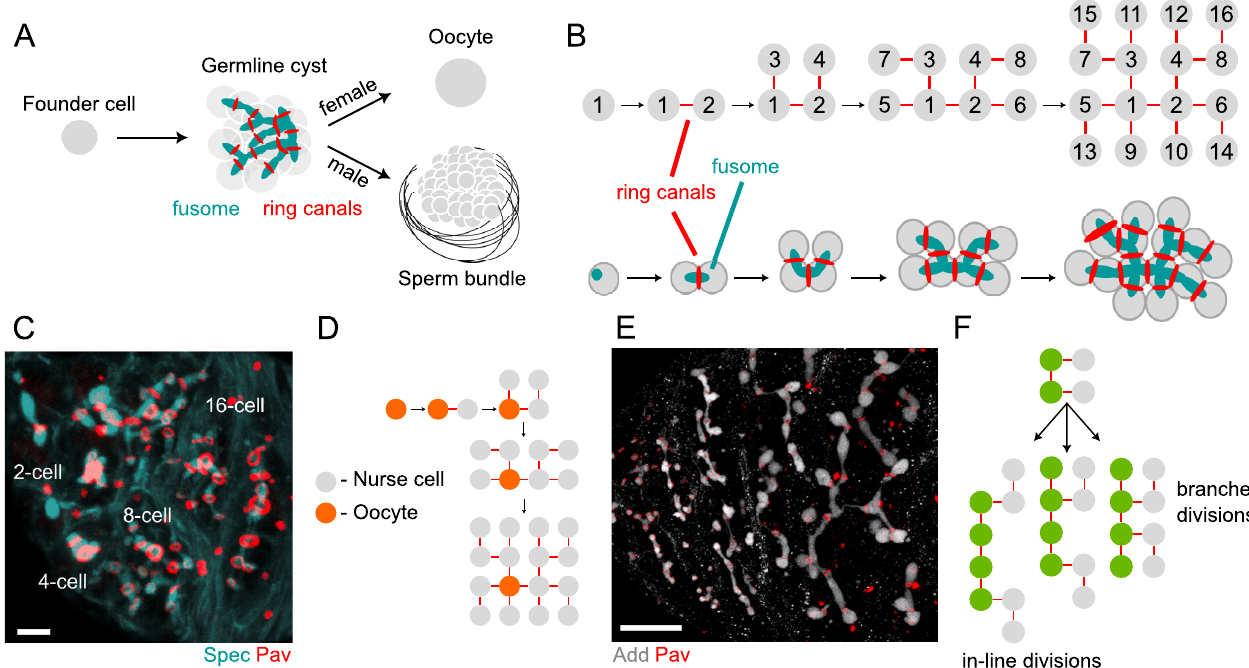
Fig 1. Fusome formation, structure, and patterns of division. A) Schematic of cyst formation during oogenesis and spermatogenesis in Drosophila melanogaster . A founder cell gives rise to a germline cyst whose 16 cells are connected through ICBs or ring canals. During oogenesis, one cell becomes the oocyte while the remaining cells serve a supporting role. During spermatogenesis, two subsequent meiotic divisions with incomplete cytokinesis generate 64 haploid spermatids. In both sexes, germline cysts contain a fusome, which permeates the cysts through the ring canals. B) Schematic of the four rounds of synchronous cell divisions that give rise to the female germline cyst, comprising 16 cells (nodes) connected by 15 ring canals (edges). The fusome (cyan) derives from the spectrosome and grows with each cell division; association of the fusome with one of the two mitotic centrosomes orients the planes of cell division, ensuring the stereotypical and maximally branched pattern in female cysts. C) Projection of a 3D image showing the fusome ( α -Spectrin, Spec) permeating the cyst through the ring canals (Pavarotti, Pav) in cysts of various sizes (2-, 4-,8- and 16-cell cysts, and a Stage 1 egg chamber (EC)). Scale bar = 5 μ m. D) Schematic for the ‘predetermination’ model for oocyte selection, which posits that the initial bias in fusome volume determines which cell becomes the oocyte; as such, oocyte identity is determined at the 1-cell stage. E) Projection of a 3D image of developing cysts during spermatogenesis, where the fusome (Adducin) and ring canals (Pav) are shown. Scale bar = 20 μ m. F) Schematic showing that cell divisions can occur in one of two ways based on the orientation that the internal cells (green) divide. If all internal cells divide to form new branches, the cyst will remain maximally branched; however, internal cells can also divide without forming new branches, thus creating in-line divisions and paving the way for topologies that deviate from the maximally branched